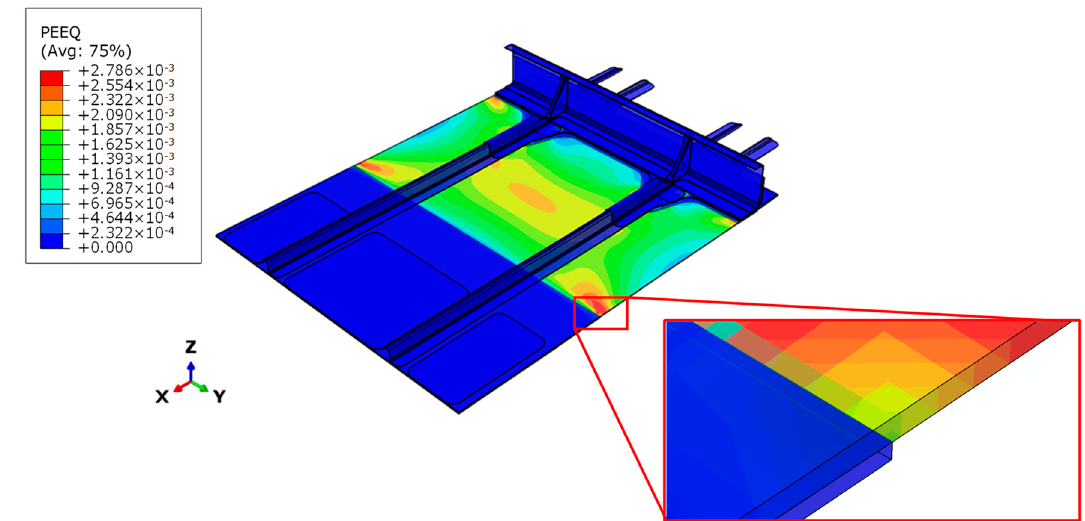
Figure 23. Plastic strains — load: 300 kN.